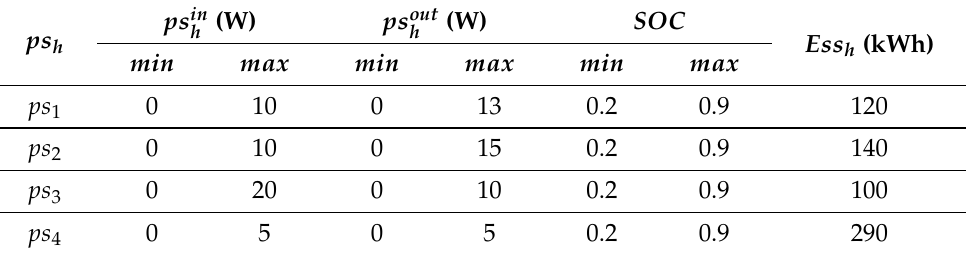
Figure 20. Simulation scenario consisting of power devices and least connections among them. Table 2. List of power storage devices with power